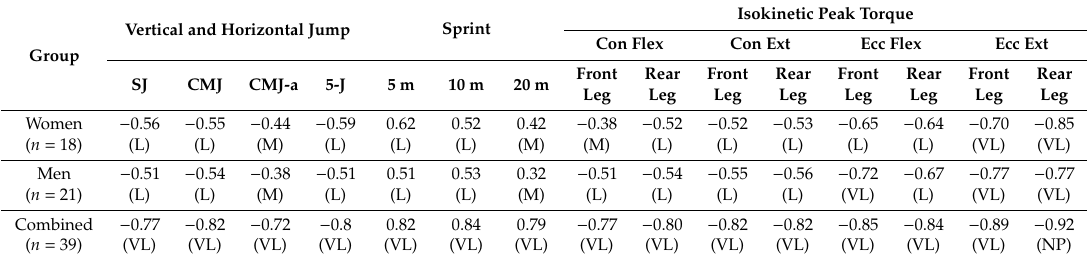
Table 3. Performance characteristics and results of absolute and relative reliability of SFCODT for fencer athletes *. Table 4. Correlation between the SFCODT and components of physical